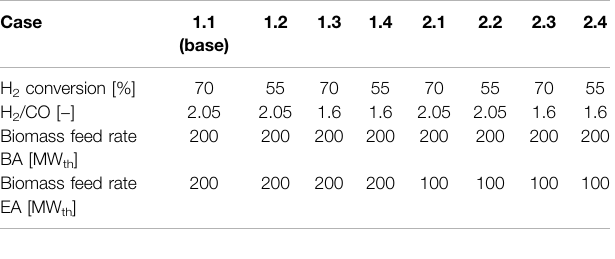
TABLE 3 | Case de fi nition for the